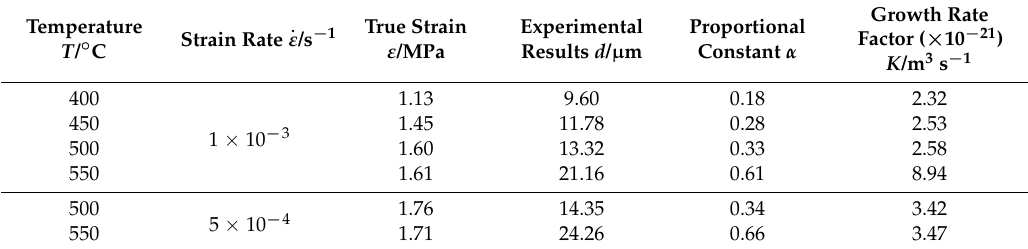
Table 3. Analysis of the grain growth for the superplastic fracture surfaces.